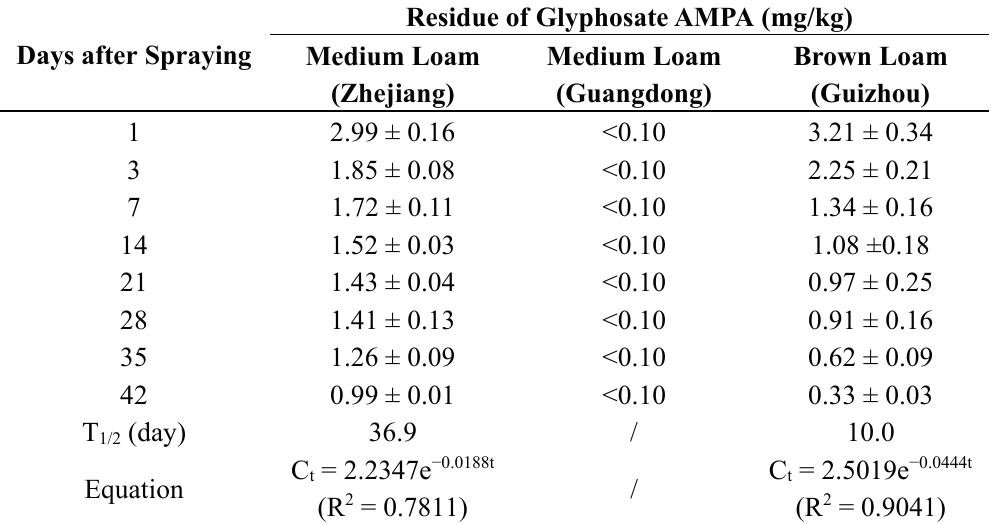
Table 3. Degradation dynamics of glyphosate soluble powder AMPA in different type of